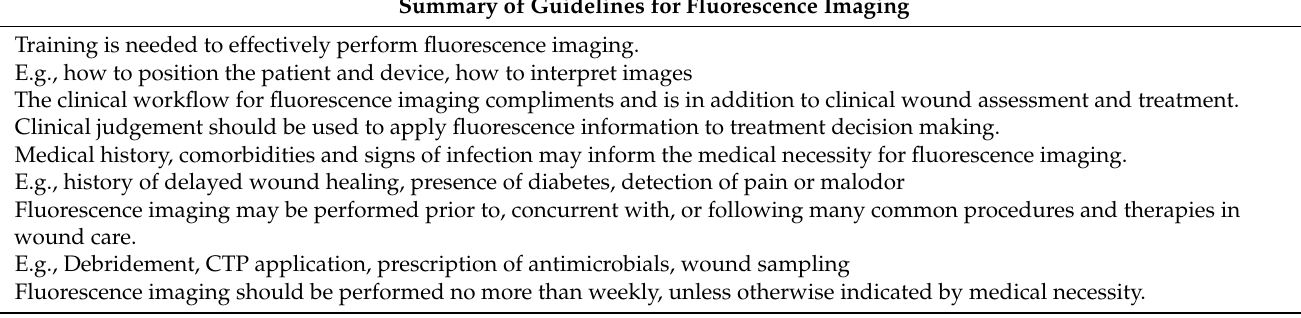
Table 6. Summary of guidelines based on Delphi consensus. Summary of Guidelines for Fluorescence